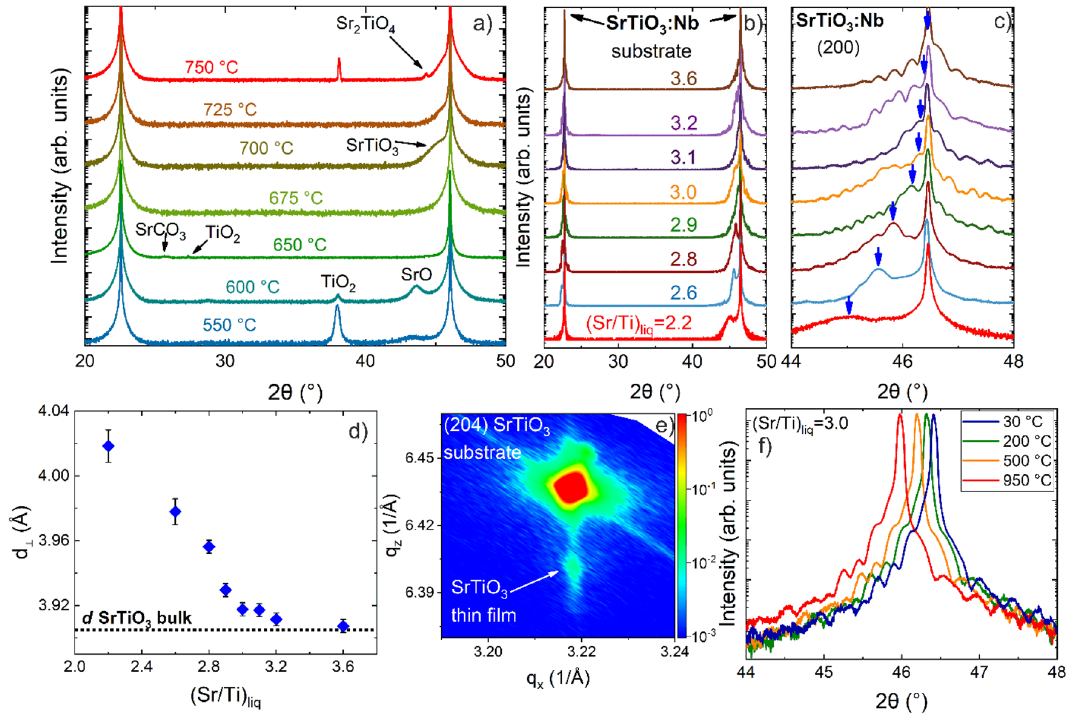
Figure 1. HRXRD patterns of ( a ) thin films grown under various substrate temperatures T s from 550 °C to 750 °C on DyScO 3 (110), and ( b ) SrTiO 3 films grown with various precursors concentration ratios in the liquid sources (Sr/Ti) liq grown on SrTiO 3 :Nb (100) in a 2θ range between 20° and 50°. ( c ) The same HRXRD scans from ( b ) with higher magnification in the vicinity of the SrTiO 3 :Nb (200) substrate peak (the film peak position is illustrated by blue arrows) with increasing (Sr/Ti) liq . ( d ) Vertical lattice parameter d ⊥ as a function of (Sr/Ti) liq . ( e ) Reciprocal space maps of the films with (Sr/Ti) liq = 2.6 in the vicinity of the (204) Bragg peak of bulk SrTiO 3 . ( f ) In-situ HRXRD patterns at different temperatures of post-annealed SrTiO 3 sample with (Sr/Ti) liq = 3.0 in pure oxygen at ambient pressure up to 950